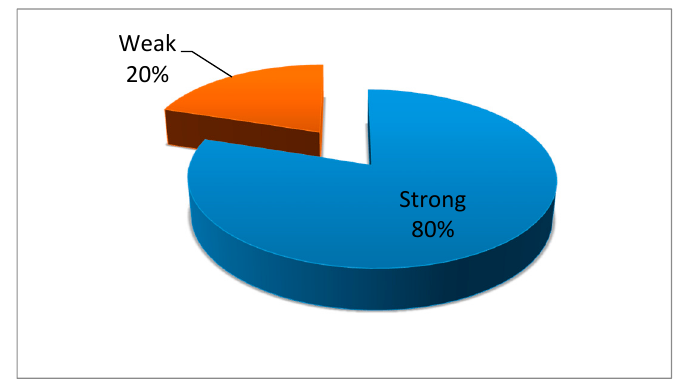
Figure 7. Level of cooperation between government agencies (according to the experts interviewed).